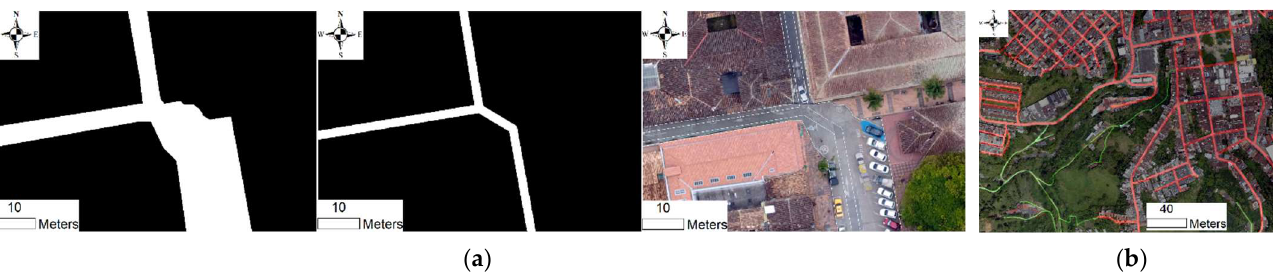
Figure 3. Type of masks. ( a ) Full-size and equal-size binary masks, and ( b ) color mask by road